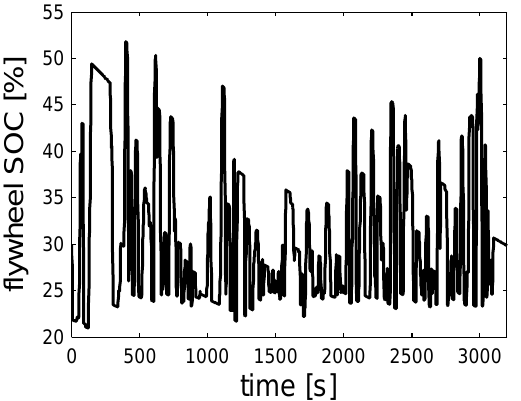
Figure 12. The flywheel State of Charge (SOC) of the HMV powetrain with the AC turned